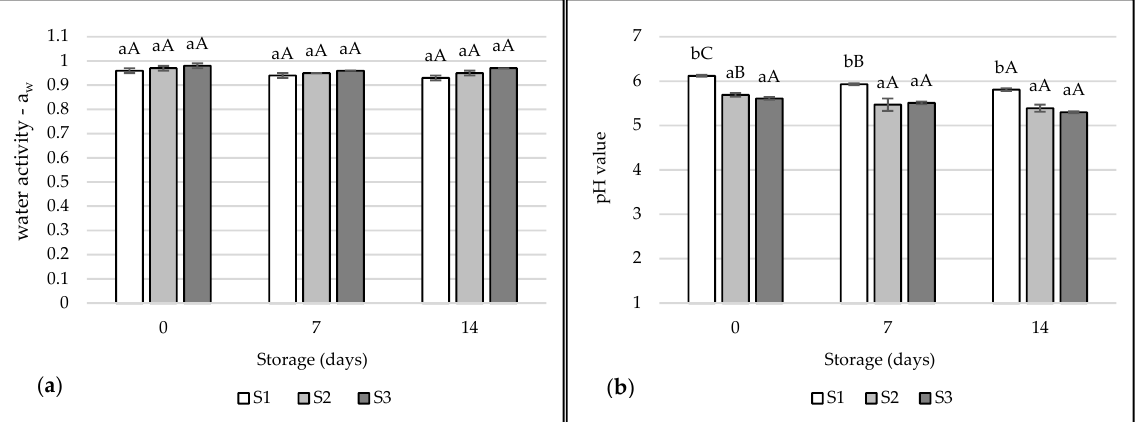
Figure 2. Water activity ( a ) and pH value ( b ) of the tested samples of pork hams. The values are expressed as means ± SD. Values marked with lowercase letters (a,b) differ significantly between treatments. Values marked with capital letters (A–C) differ significantly between storage times.